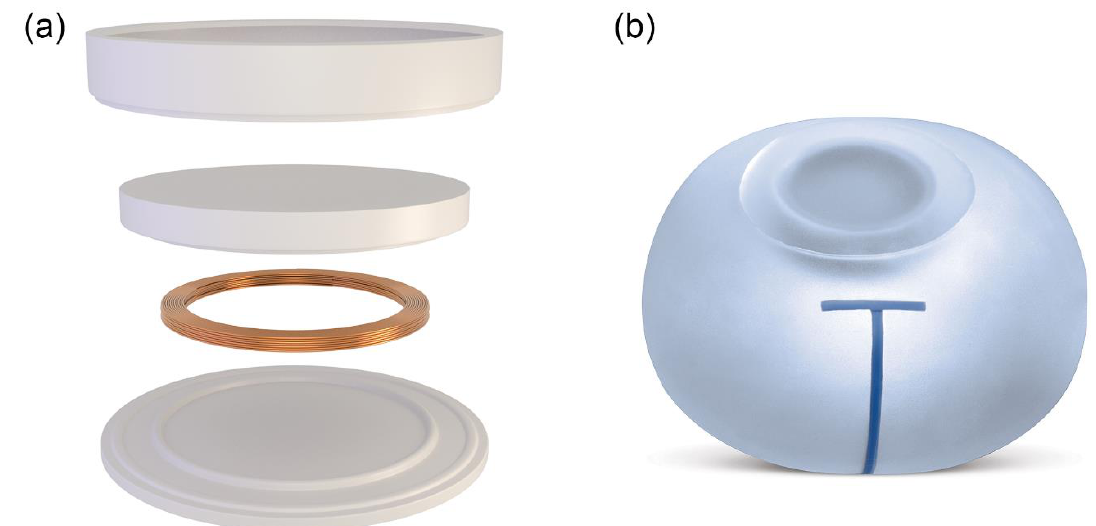
Figure 1. The schematic diagram of the radio frequency identification port ( a ) in the Motiva Flora ® tissue expander ( b ).